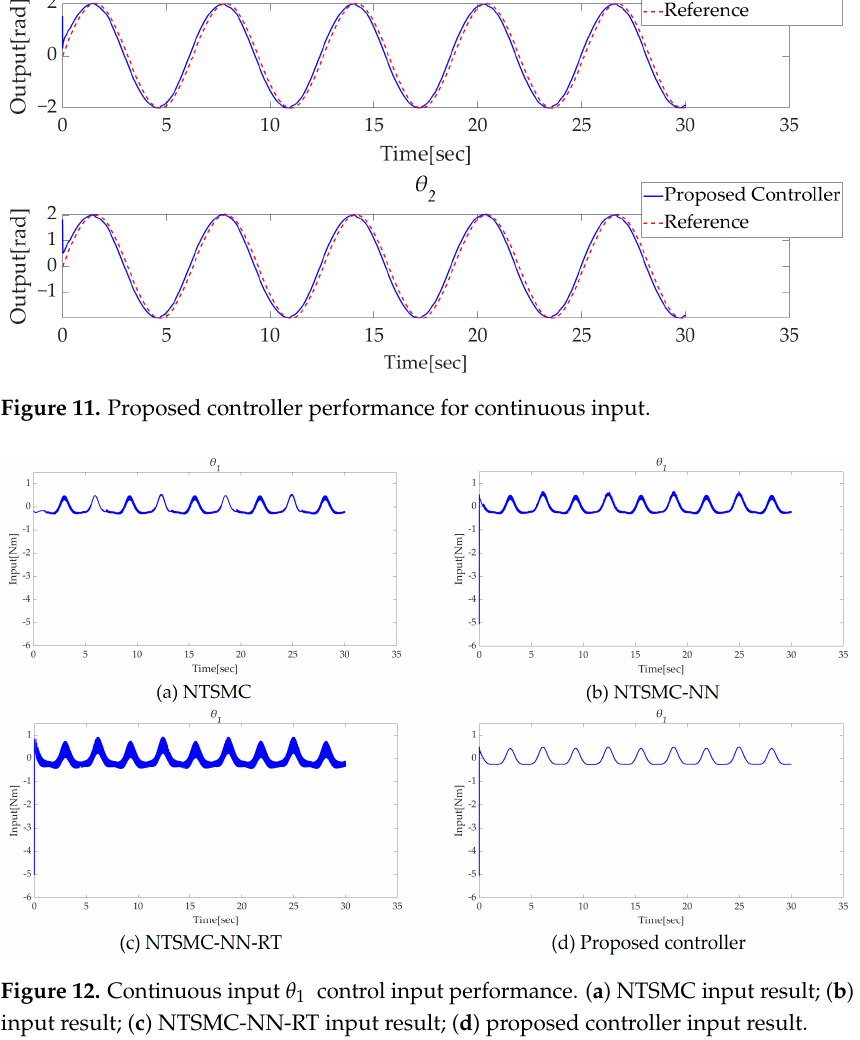
Figure 12. Continuous input θ 1 control input performance. ( a ) NTSMC input result; ( b ) NTSMC-NN input result; ( c ) NTSMC-NN-RT input result; ( d ) proposed controller input result.